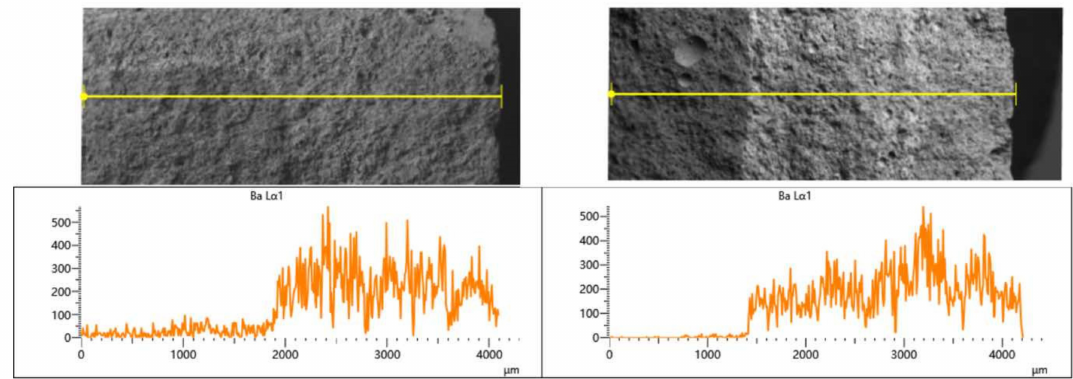
Figure 8. Line scan results of specimens; ( left ): the treated specimen before water supply, (( upper ): SEM image with the yellow line analyzed by EDX, ( lower ): line scan results of the barium element), ( right ): treated specimen after water supply, (( upper ): SEM image with the yellow line analyzed by EDX, ( lower ): line scan results of the barium